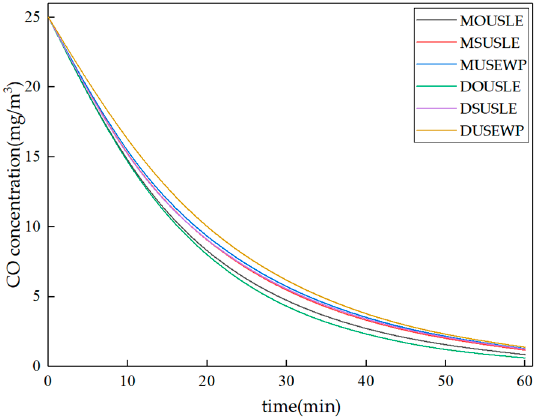
Figure 12. The curve of CO concentration changing with time in the room at a height of 1.2 m. From the curve, we can see that all of the six schemes have a good dilution effect on indoor CO. The CO concentration in the room can be reduced from 25 mg/m 3 to below the standard value (10 mg/m 3 ) within 20 min. The dilution rate is the fastest when the ventilation scheme is adopted with the DOUSLE, and the dilution time is 16.6 min. The dilution rate is the slowest when the ventilation is adopted with the DUSEWP, and the dilution time is 20.0